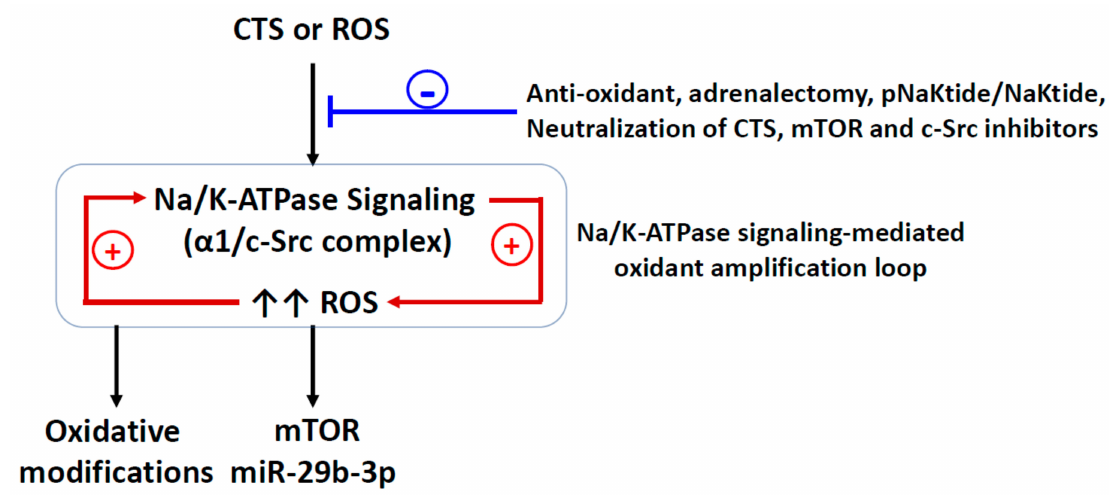
Figure 1. Schematic illustration of the concept of the Na / K-ATPase signaling-mediated oxidant-amplification loop. + , stimulating e ff ect; - attenuating e ff ect; CTS, cardiotonic steroids; ROS, reactive oxygen species; α 1, Na / K-ATPase α 1 subunit; mTOR, the mammalian target of rapamycin; miR-29b-3p,